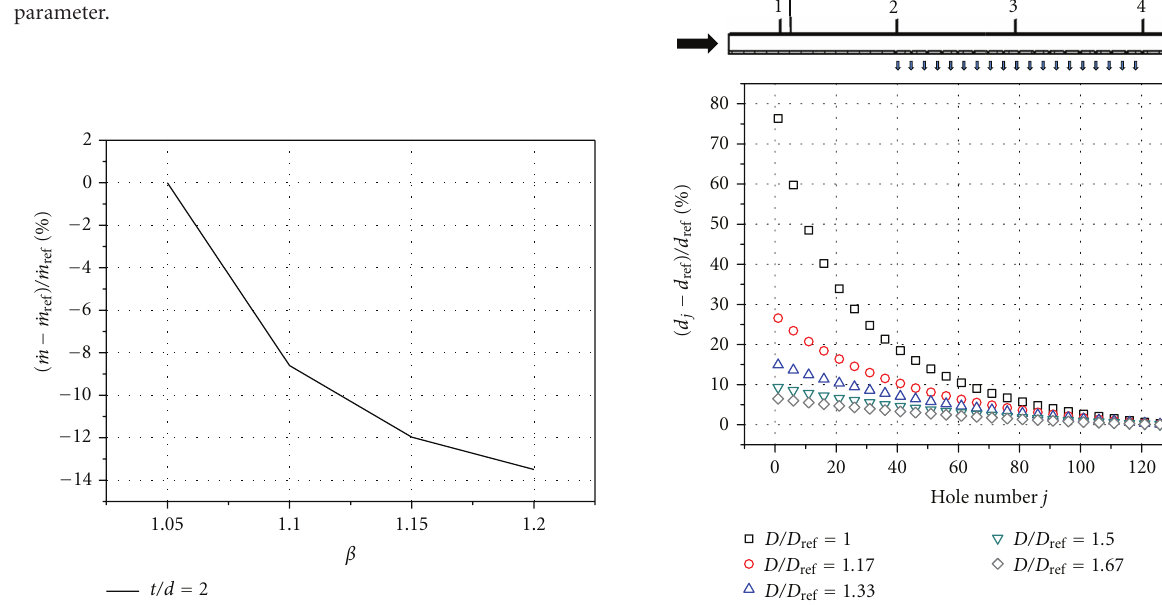
Figure 17: Nozzles’ diameter distribution across the manifold β = 1 . 05, t/d = 2 varying the manifold diameter ( d ref = 1mm and D ref = 12